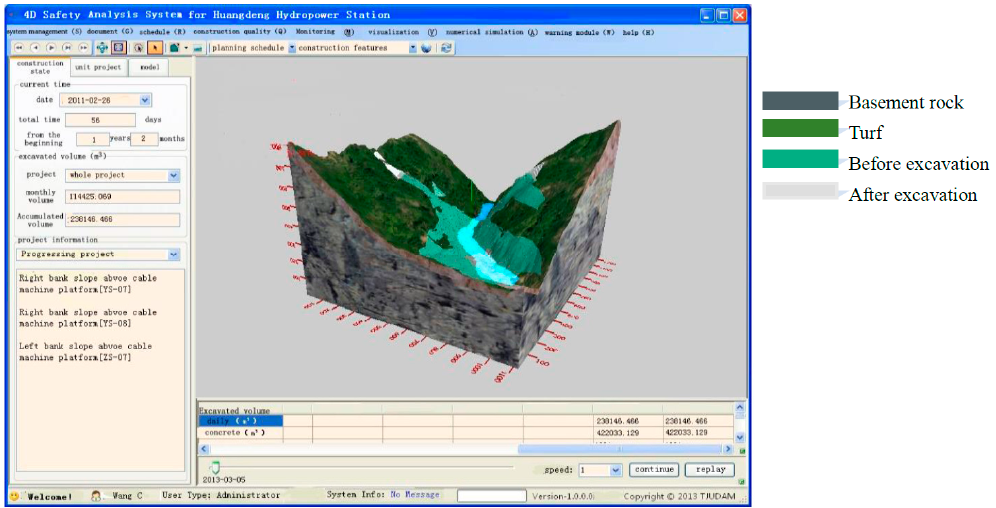
Figure 7. System interface for time-dependent slope construction (translated from Chinese Interface).